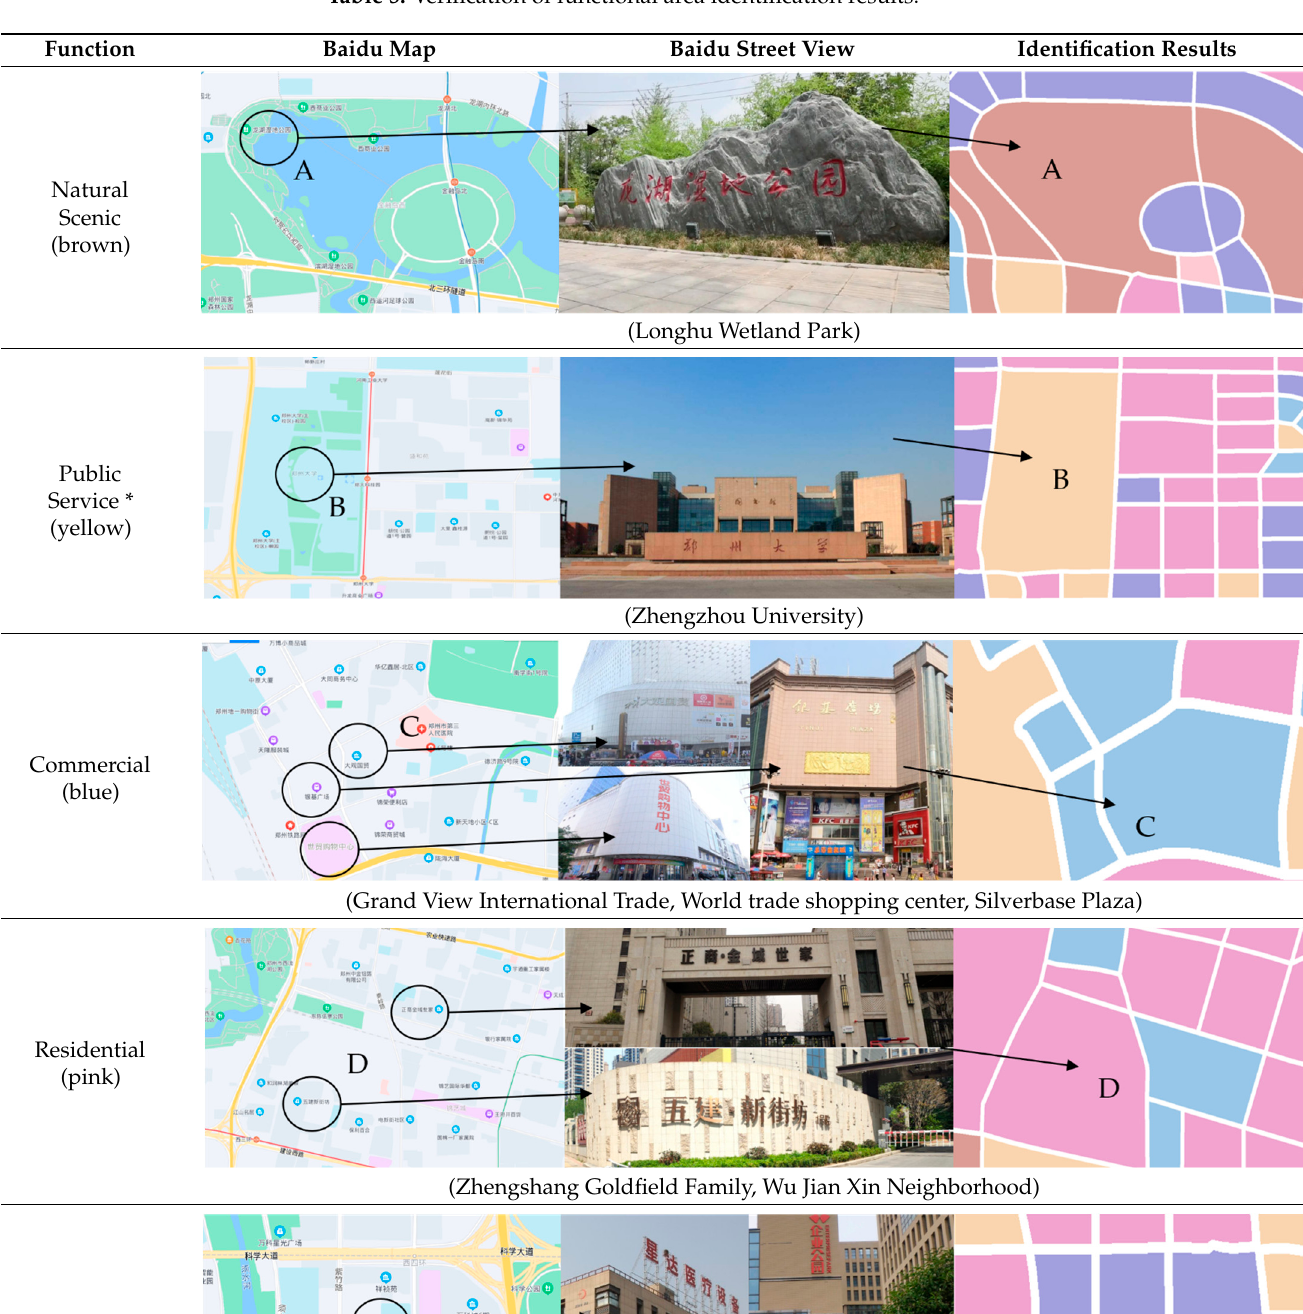
Table 5. Verification of functional area identification